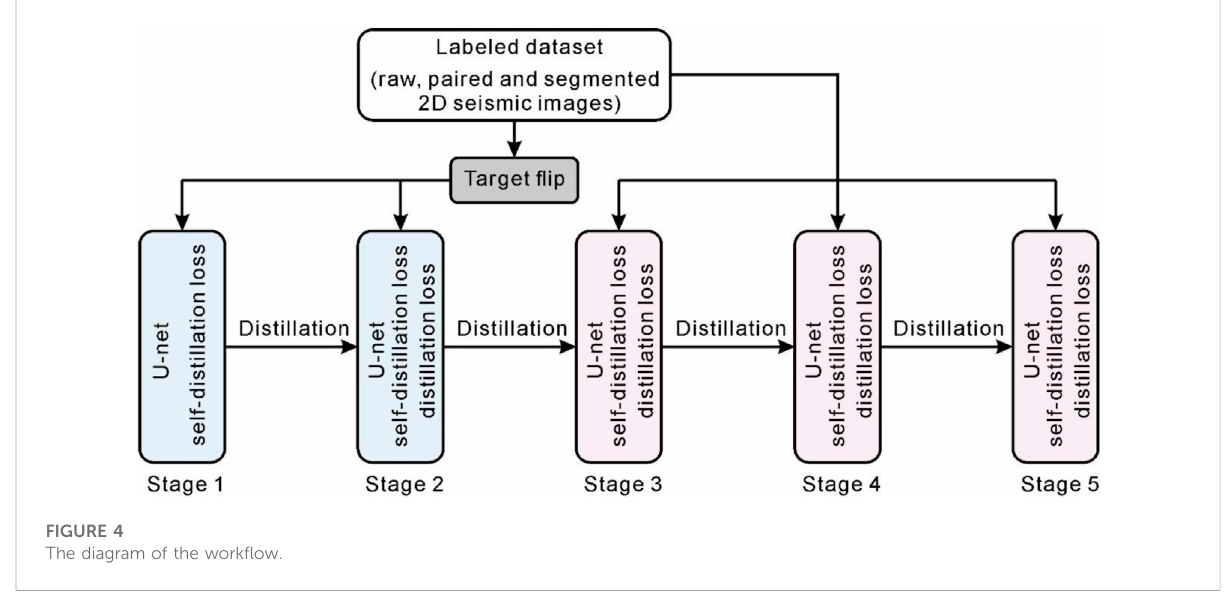
FIGURE 4 The diagram of the work fl